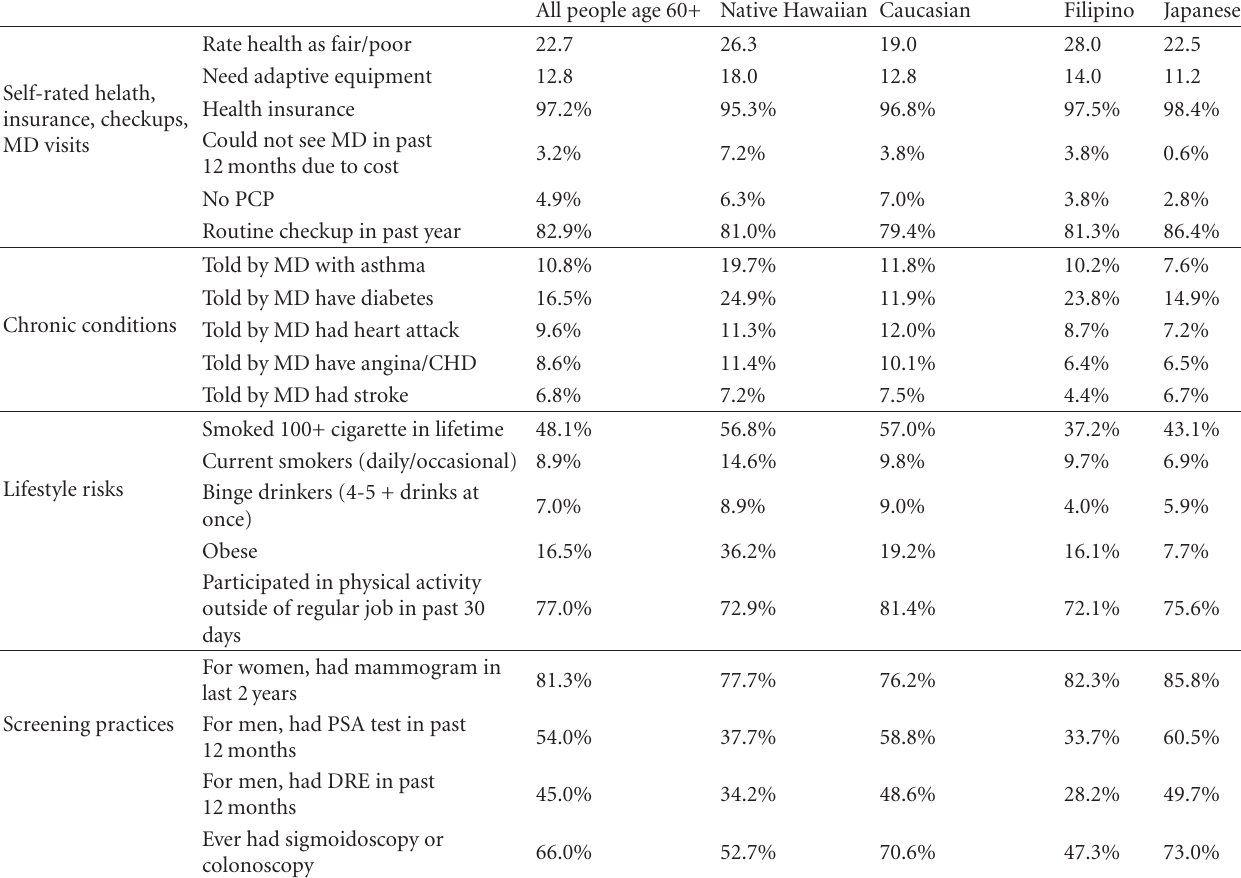
Table 3: Health indicators in 60+ population by ethnicity, HBRFSS, 2005–07. All people age 60+ Native Hawaiian